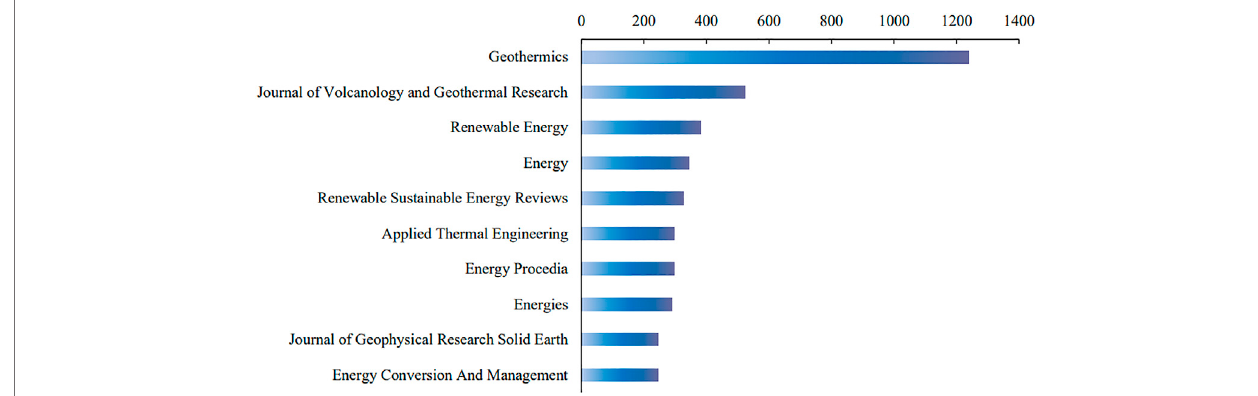
FIGURE 2 | The top 10 journals with publications in geothermal research.